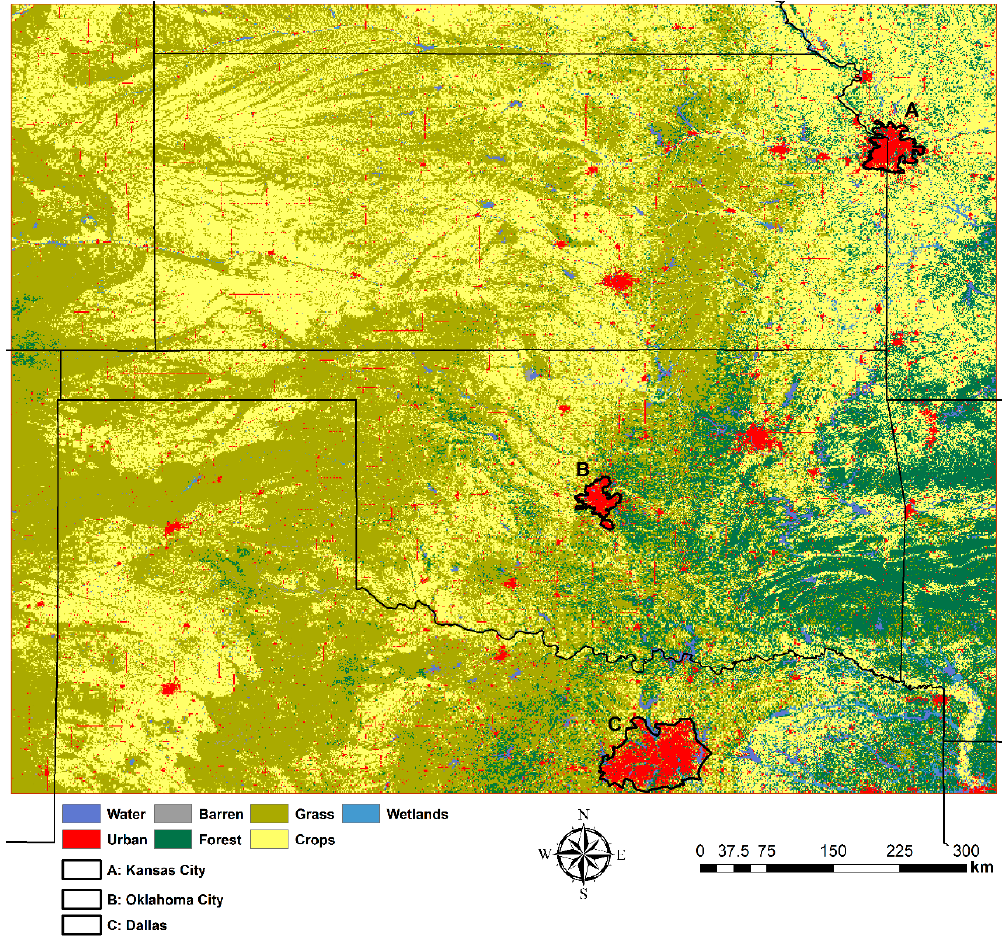
Figure 2. The land cover types in the study area after reclassifying 2011 NLCD into seven main types.